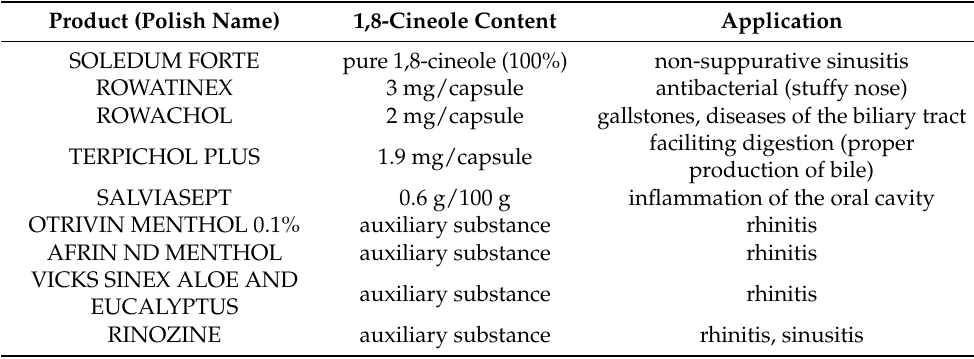
Table 3. Medicinal preparations containing